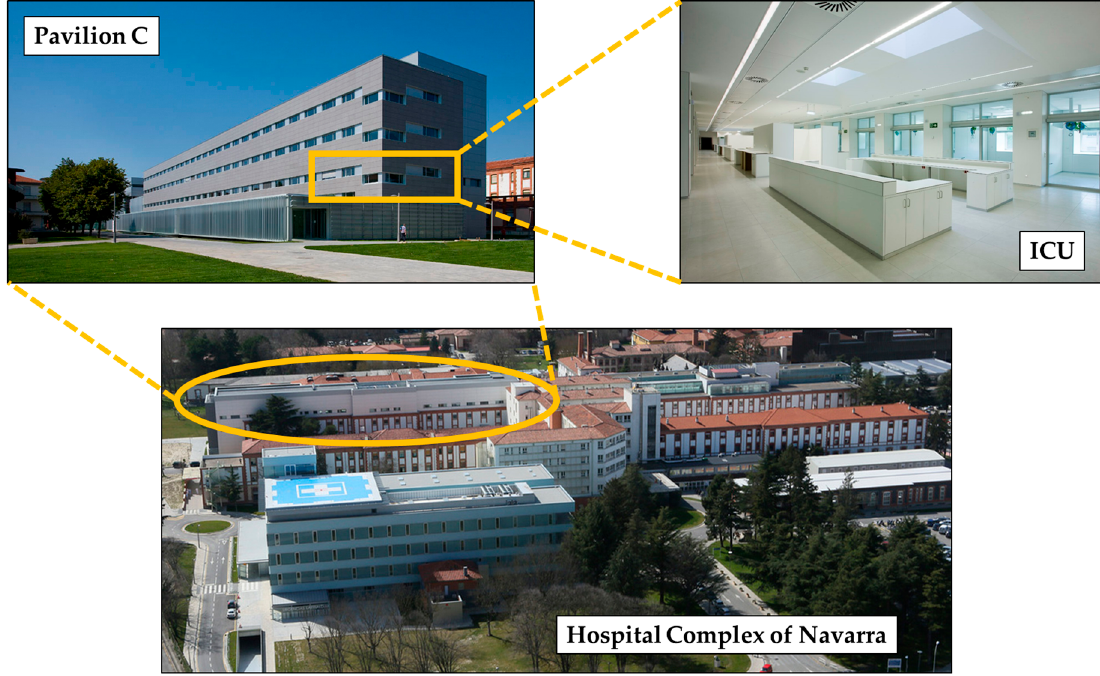
Figure 1. Scenario under analysis: the ICU-A of the HCN, located in Pamplona/Iruña, Navarre, Spain.